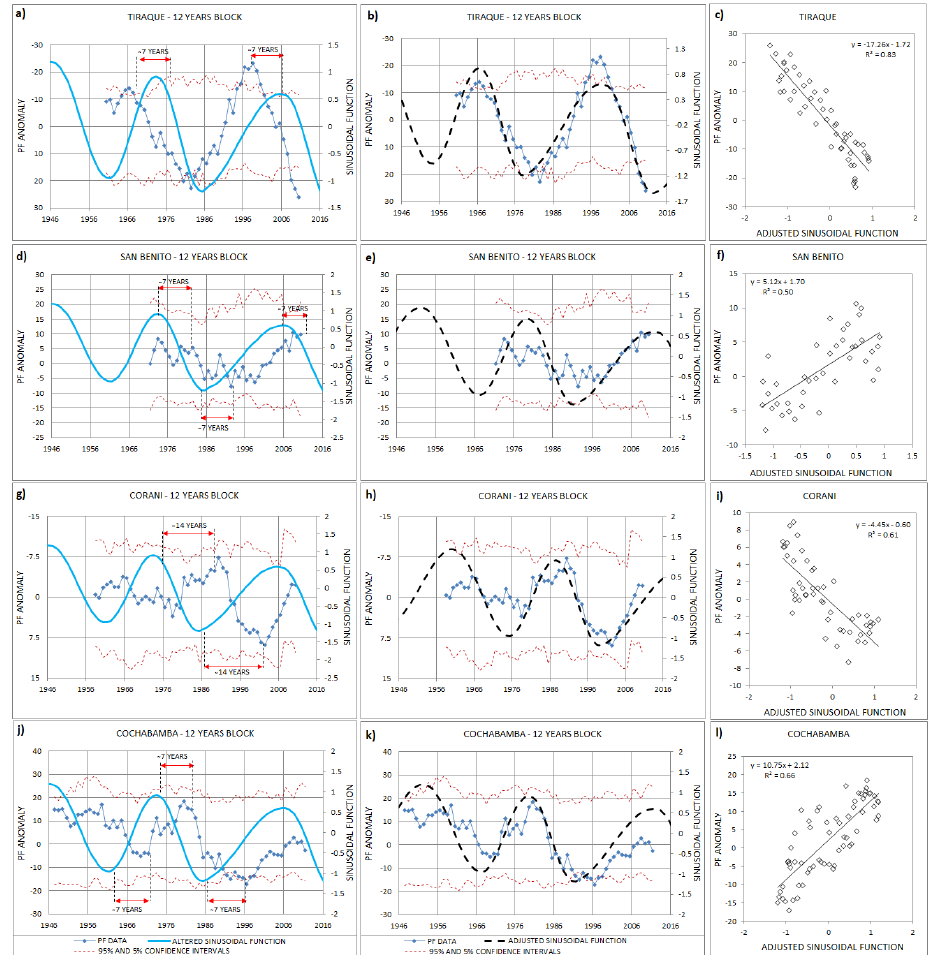
Figure 5. ( a – l ) QPM climate anomaly based on precipitation data and comparison with the altered SOI sinusoidal function (left column). Sinusoidal approximation of the QPM climate anomaly based on the precipitation data (center column). Goodness-of-fit evaluation of the original and altered sinusoidal approximation (right column). The meteorological stations from top to bottom are at Tiraque, San Benito, Corani and Cochabamba, respectively.